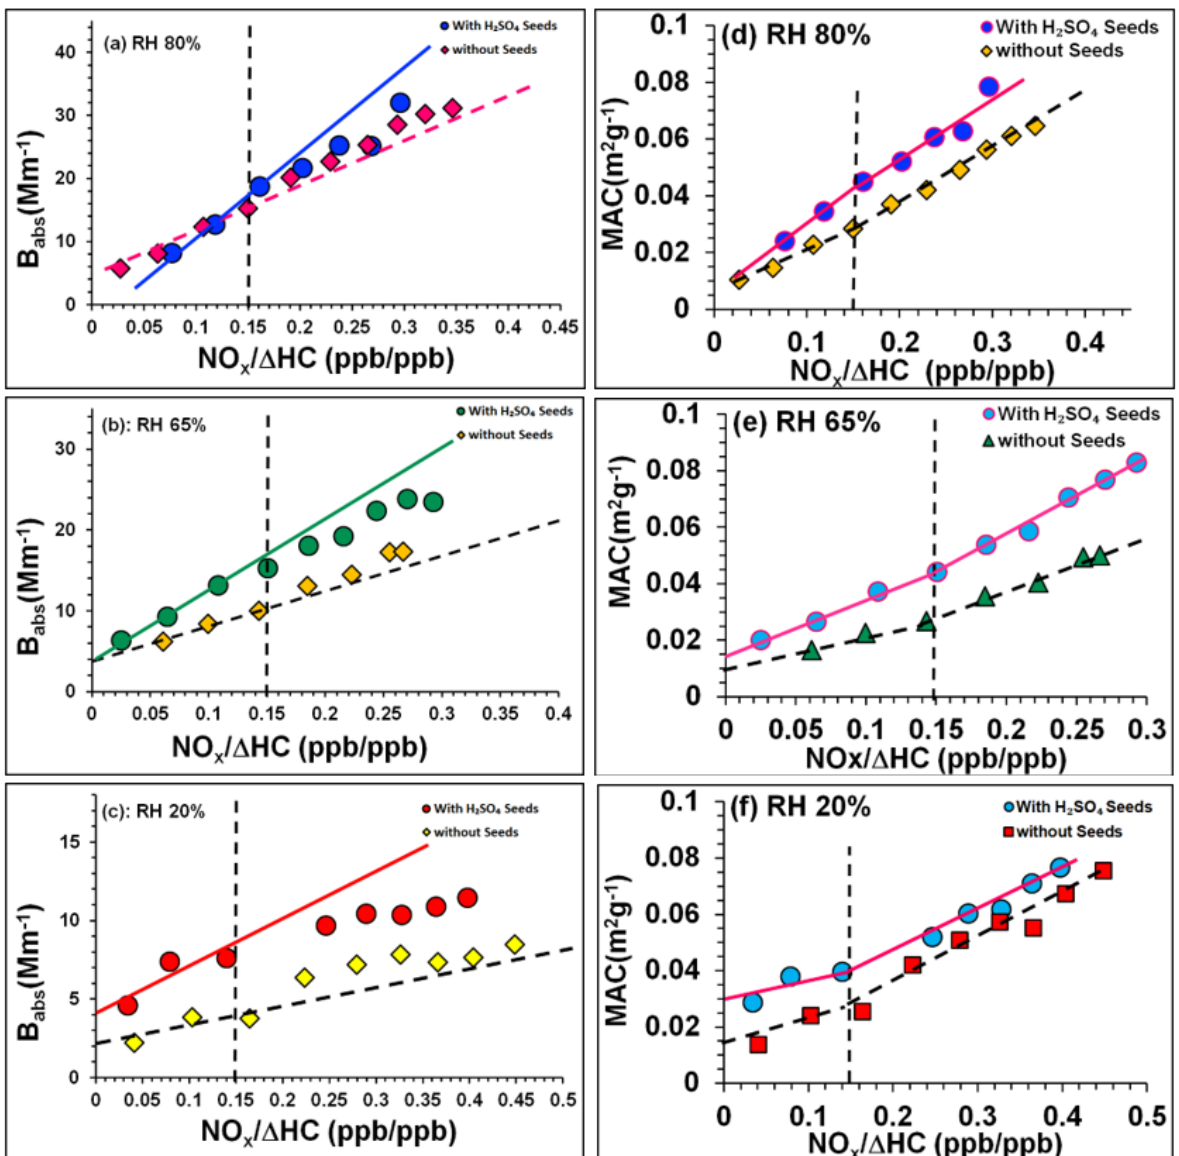
Figure 13. ( a – f ): Effects of acidity, NO x and RH on the B abs and MAC of toluene SOA. (i) B abs as a function of [NO x ]/[ ∆ HC] in H 2 SO 4 seeded and non-seeded experiments at ( a ) 80%, ( b ) 65%, and ( c ) 20% RH. (ii) MAC as a function of [NO x ]/[ ∆ HC] in H 2 SO 4 seeded and non-seeded experiments at ( d ) 80%, ( e ) 65%, and ( f ) 20% RH. The solid and dotted lines in Figure 13 ( a – c ) are eye guides showing the trends in B abs for NP SOA in the H 2 SO 4 seeded and non-seeded cases, respectively; eye guides for the NR case are not shown. Conversely, in Figure 13 ( d – f ), the solid and dotted lines are eye guides for both the NP and NR SOA in H 2 SO 4 seeded and non-seeded experiments, respectively. The solid and dashed lines are included to guide the eye.